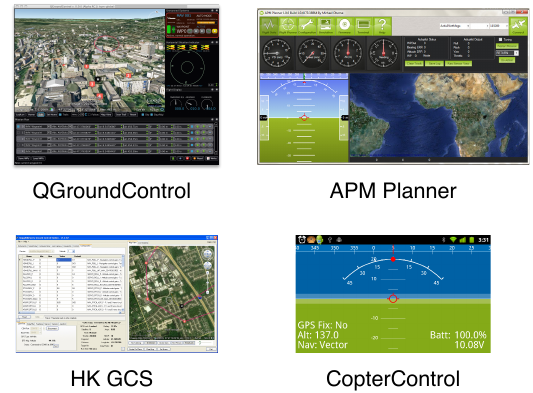
Figure 8: Ground control stations using MAVLink: QGround- Control (Win/Lin/Mac), APM Planner (Win), HK GCS (Win), CopterControl (Android phones).